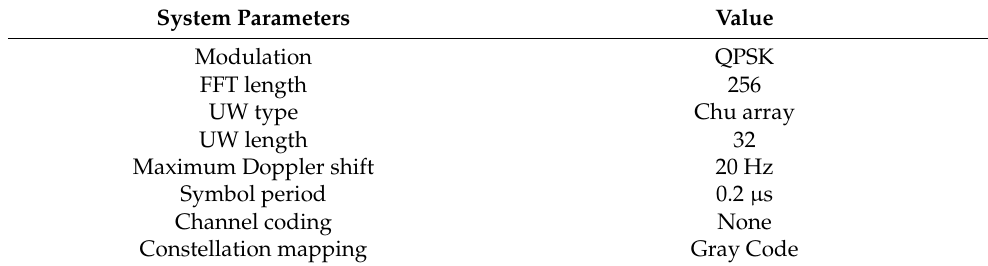
Table 3. Simulation parameters of SC-FDE